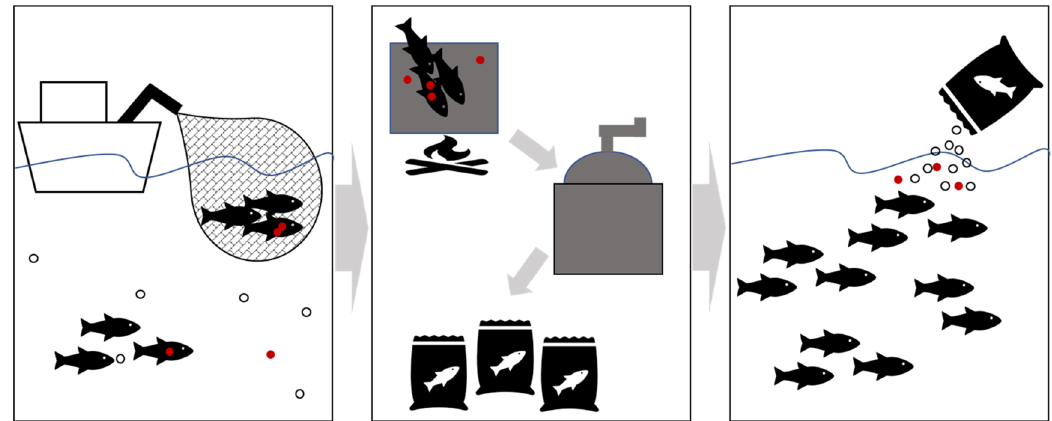
Figure 4. Fishmeal as a pathway for microplastics to the marine environment from capture fisheries via fishmeal production to mariculture feed. Food particles (open circle), microplastics (red filled circle). Microplastic fragmentation possible during fishmeal production steps (heating and grinding) or through contamination, leading to increased microplastic concentrations fed back into the